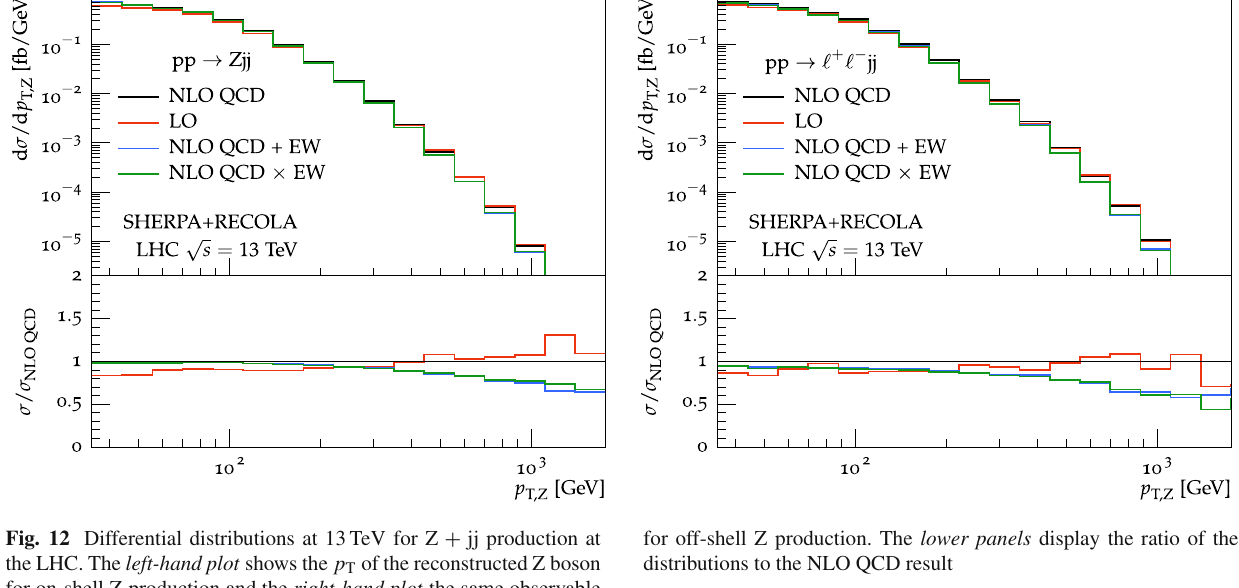
Fig. 11 Differential distributions at 13TeV for Z + j production at the LHC. The left-hand plot shows the p T of the Z boson for on-shell Z production and the right-hand plot the same observable for the recon-